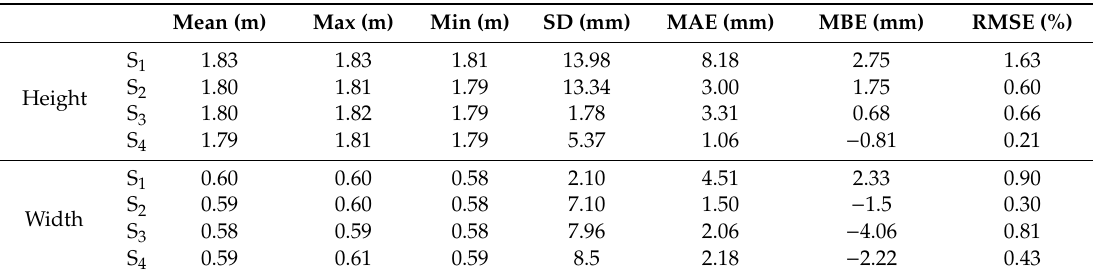
Table 2. Height and width results for each side (S) of the metal box (n = 6), maximum (Max),